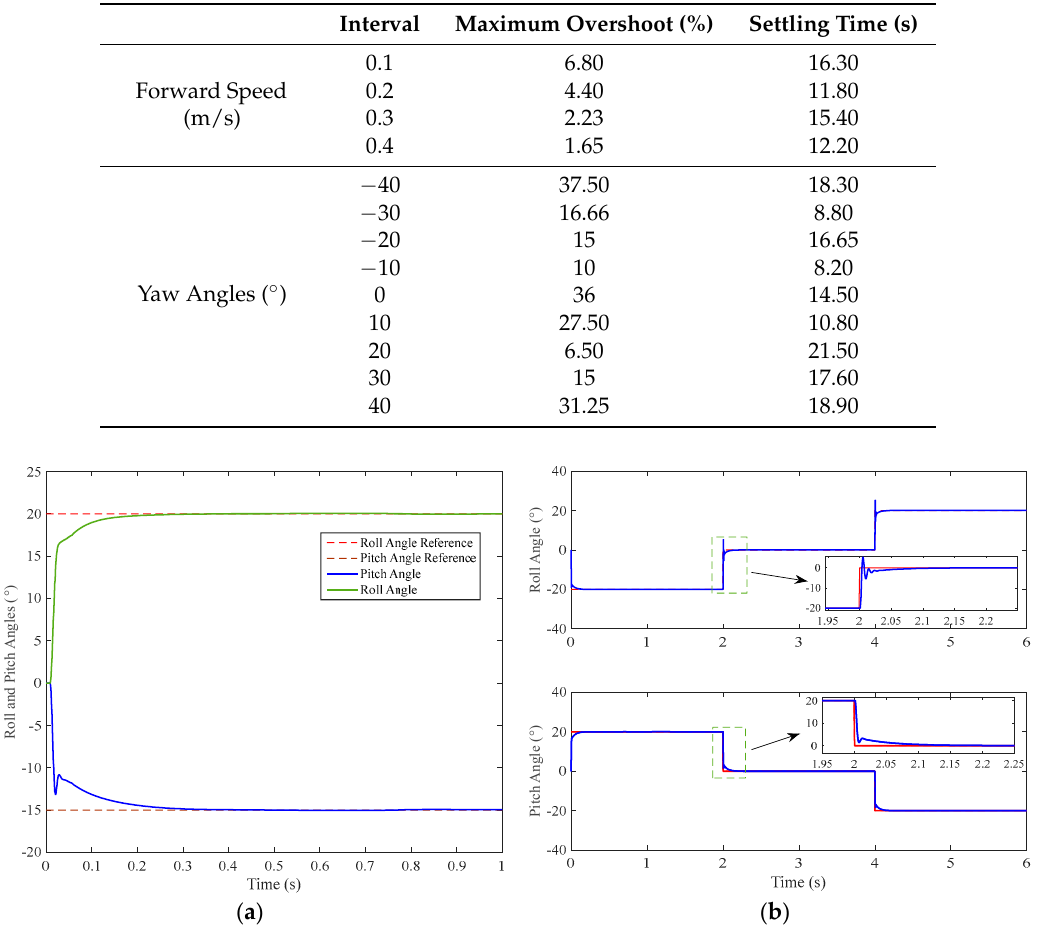
Table 2. The simultaneously closed loop control performance of the roll and pitch motions for step and stairs references.